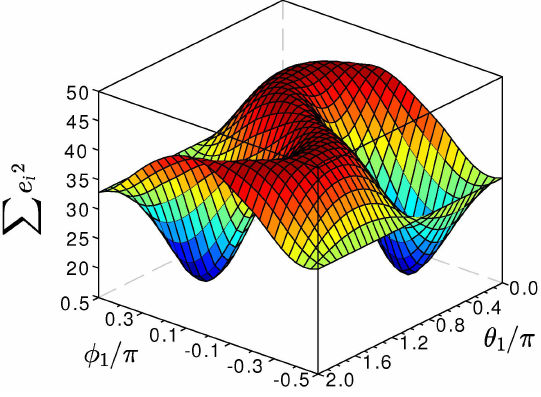
, j ) of the error in the kinematic constraint (3). The two 1 2 and − j , of the joint axis direction 1 1